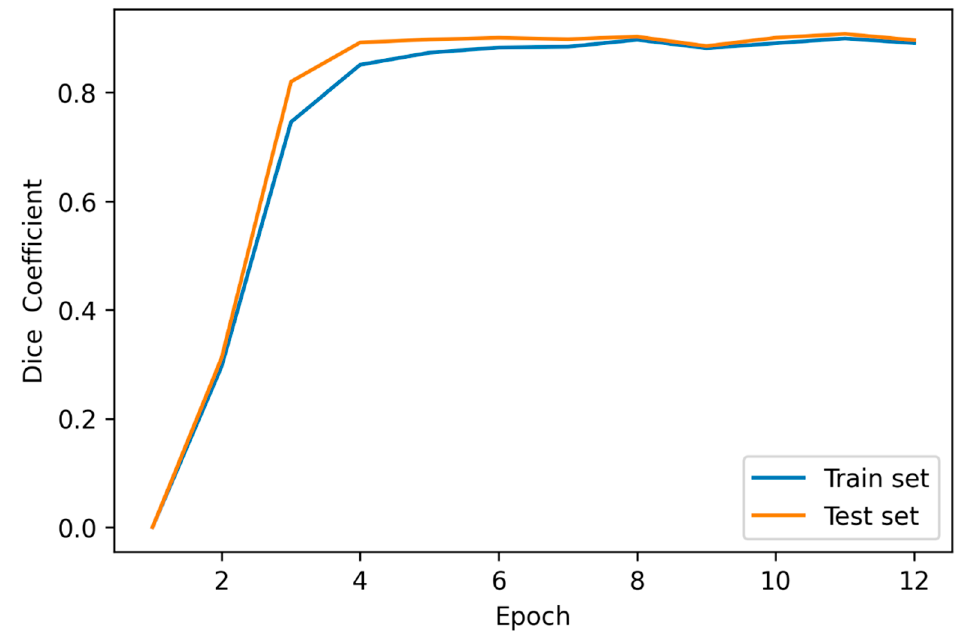
Figure 2. Dice coefficients of Epi Detector during training.